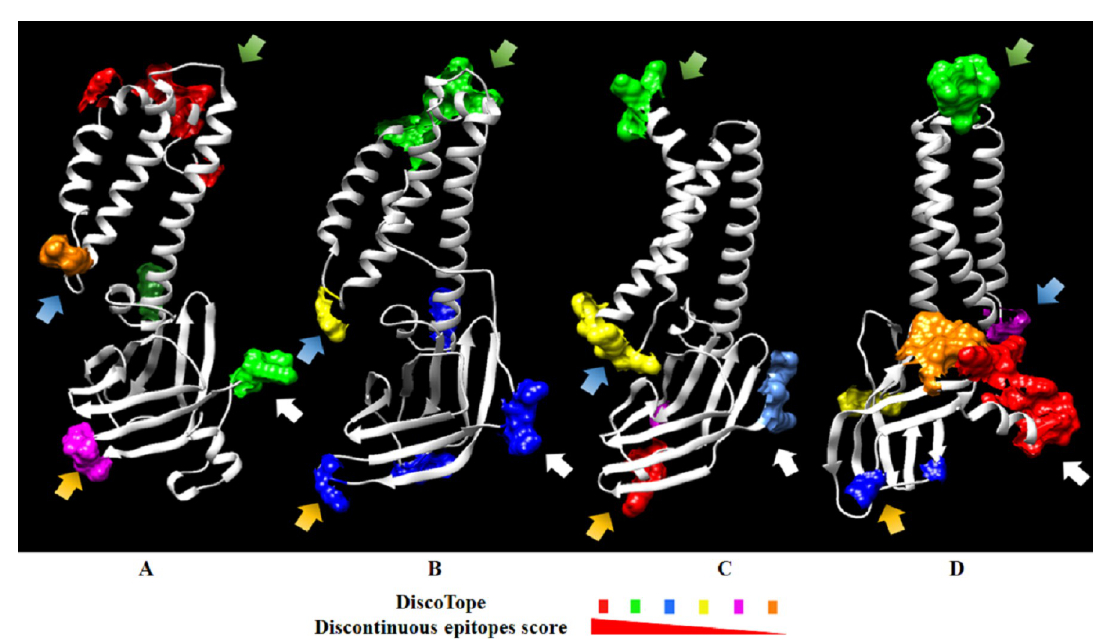
Fig 5. Discontinuous epitopes predicted in DiscoTope from CV777 and 2013MMV M protein and SARS-CoV-2 protein M models. A) CV777 M protein. B) 2013MMV M protein. C) SARS-CoV-2 M protein from AlphaFold. D) SARS-CoV-2 M protein from Feig lab. Predicted discontinuous epitopes are highlighted in the 3D model with different colors to represent the score. The epitope with the highest score is represented in red up to the lowest value in orange. The score decreases from the epitopes marked in green, blue, yellow and pink. Arrows with the same color indicate discontinuous epitopes located in equivalent regions in the models. An additional color (light blue) show residues that were not predicted in ElliPro. Colored residues in each epitope are indicated in S3 Table.